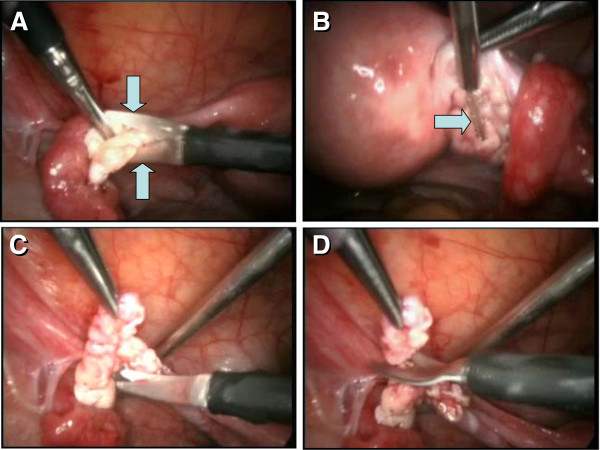
Snapshots from the collection of the OSC and ovarian biopsy from POF ovary by a laparoscopy. OSC are collected by scratching the ovarian surface with scissors (arrows in A) and with a brush (arrow in B). Ovarian biopsies (C and D) are collected from each ovary. For a complete video see Additional file
3, Video S2.